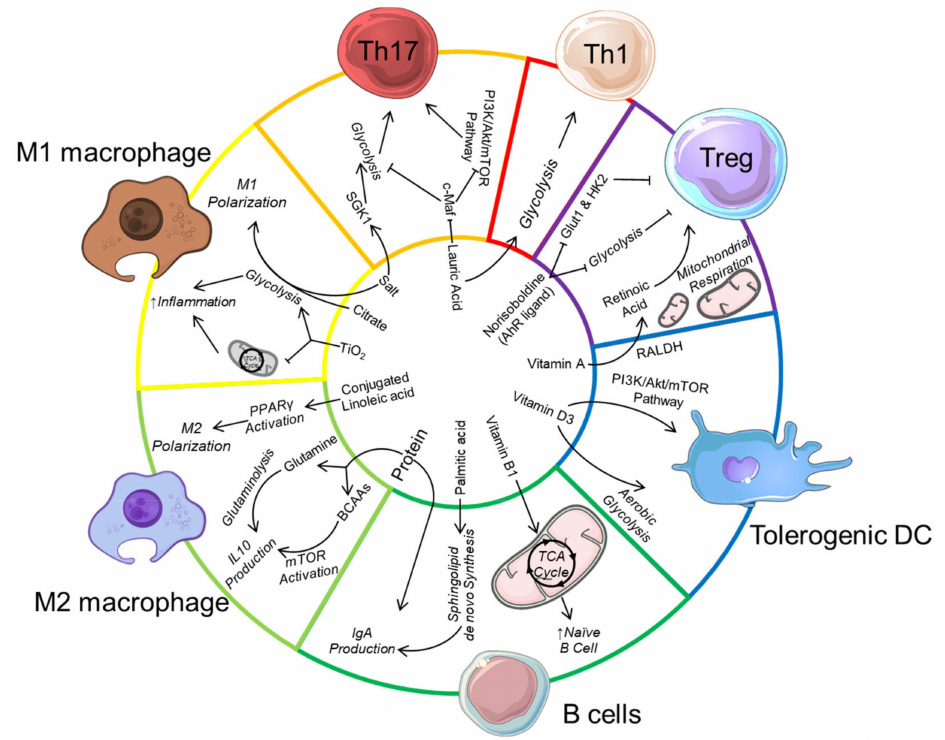
Figure 1. Impact of dietary-derived metabolites on host immunometabolism and gut immune cell